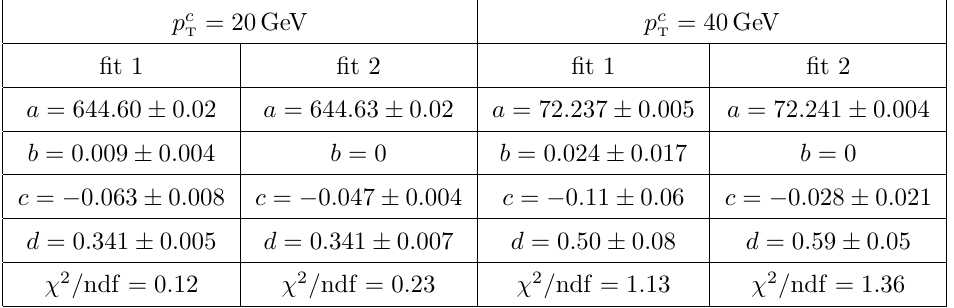
Table 1 . Results of the fit of the T ( λ ) function, defined in eq. (2.16) and illustrated in figure 9. The fit function is given in eq. (4.2). In the first fit, corresponding to the blue lines in the figures, b in unconstrained, while in the second fit, corresponding to the red lines, b has been set to 0. The last line corresponds to the associated reduced χ 2 .